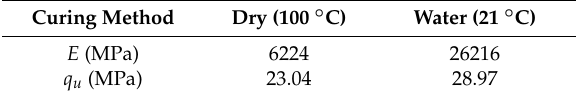
Table 3. Young’s modulus and uniaxial compressive strength of G-class cement